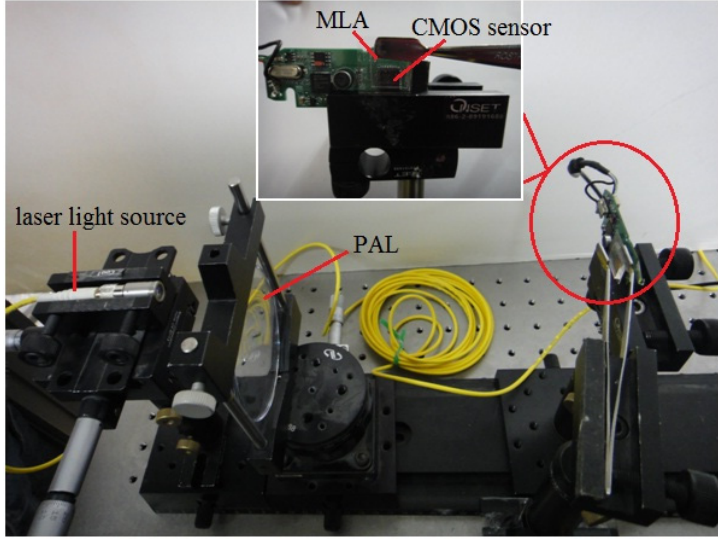
Figure 8. The experiment setup for measuring a wavefront aberration of testing lens (PAL) by using our fabricated MLA and SHWS.